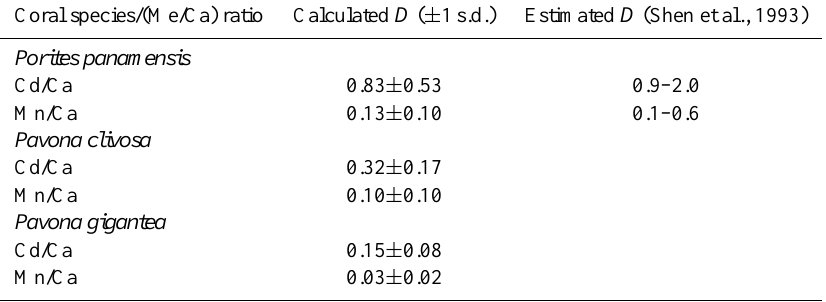
Table 2. Distribution coefficients ( D ) calculated ( ± 1s.d.) for the Cd/Ca and Mn/Ca ratios of the coral species studied, considering the average Cd and Mn concentration in the surface layer of the southern Gulf of California (station 19, Delgadillo-Hinojosa et al., 2001, 2006) and the average Ca concentration in seawater (of 10.3mM, Bruland, 1983).